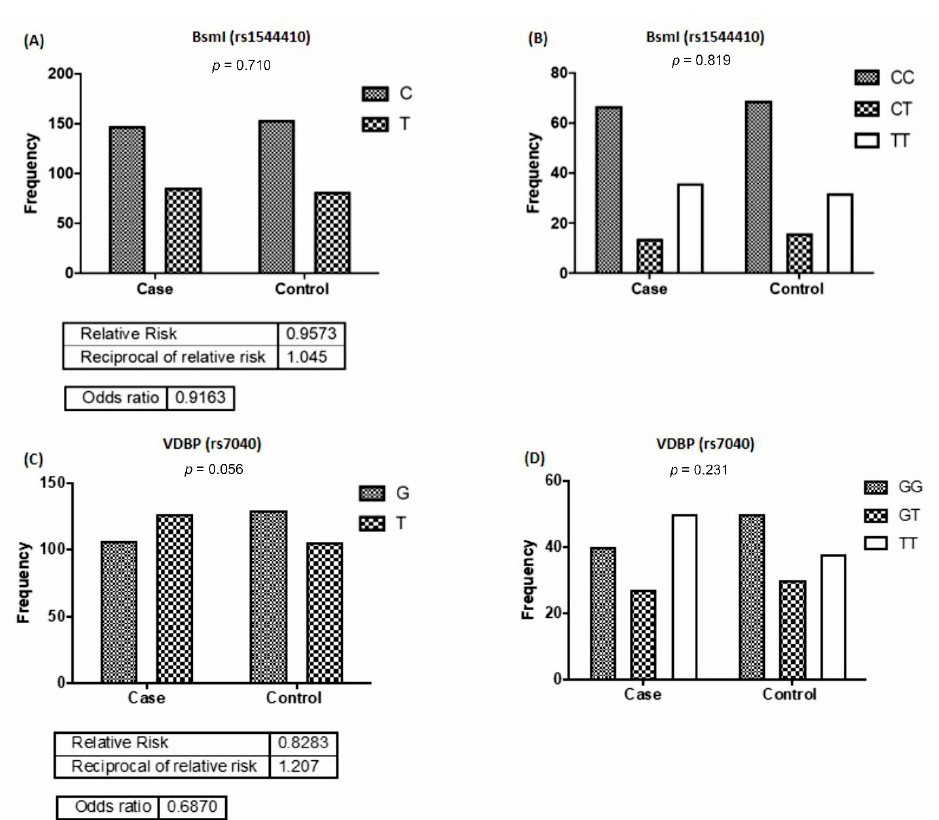
Figure 3. Allele and genotype frequencies of Bsm I and vitamin D-binding protein (VDBP) rs7040 polymorphisms in the studied groups. Comparing the Bsm I ( A , B ) and rs7040 ( C , D ) polymorphisms between kidney recipients and control groups.